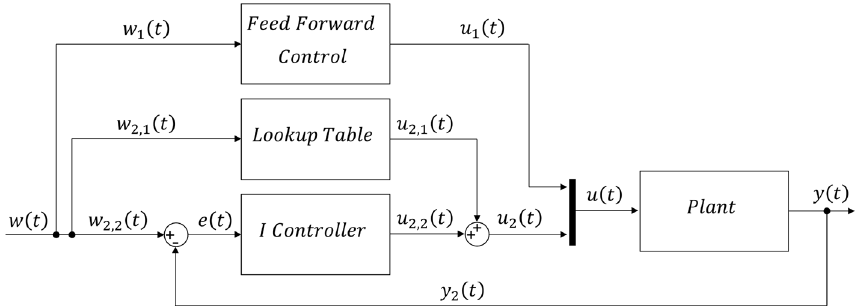
Fig. 4 Schema of the concept “characteristic field based control” [own